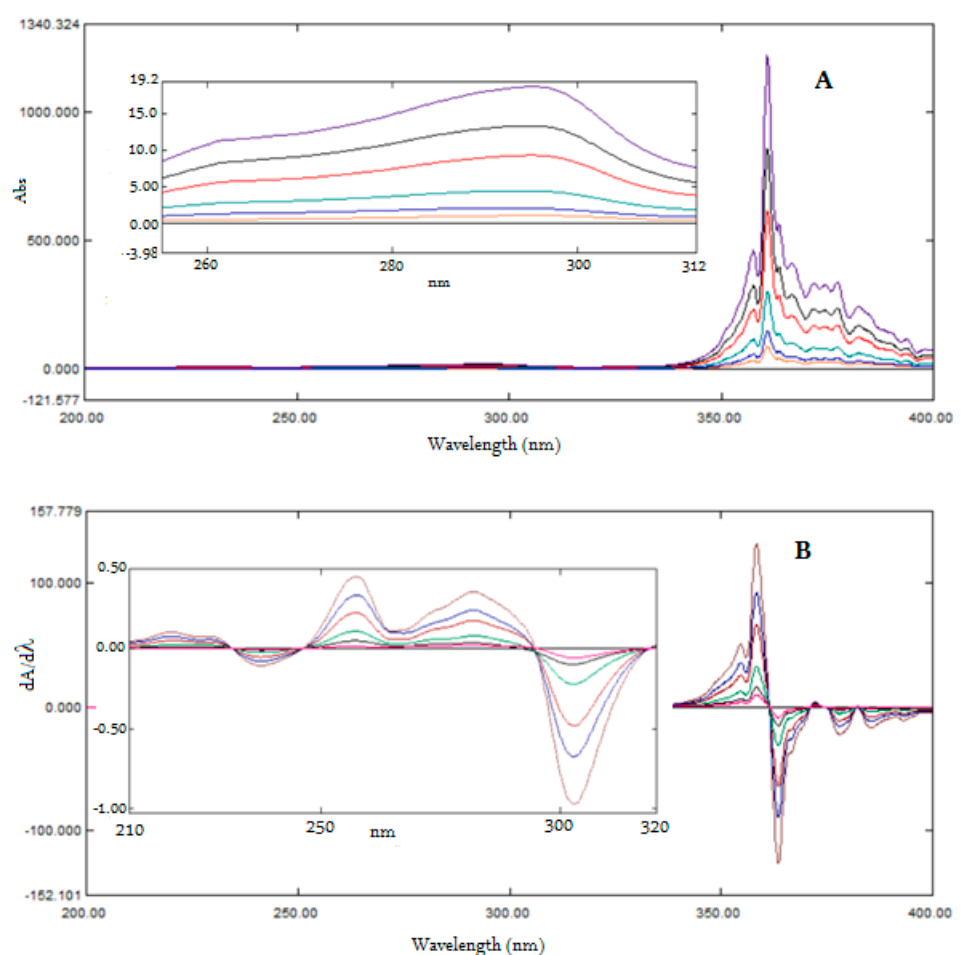
Figure 4. Ratio UV spectra MOX (1–16 µg/mL) using 4 µg/mL solution spectra of FLX as devisor ( A ), First derivative of ratio spectra of MOX (1–16 µg/mL, B ) with enlarged part for 200 to 320 nm.